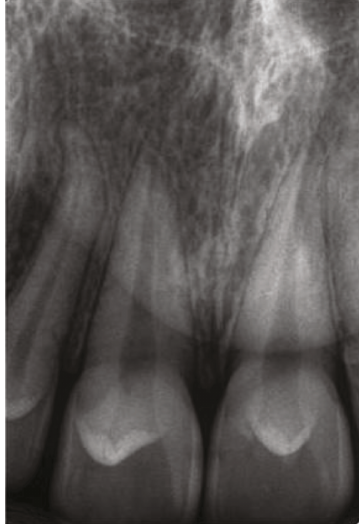
Figure 24: Case 5: occlusal interference by talon cusps. Proclination of upper anterior teeth occurs as a result of this